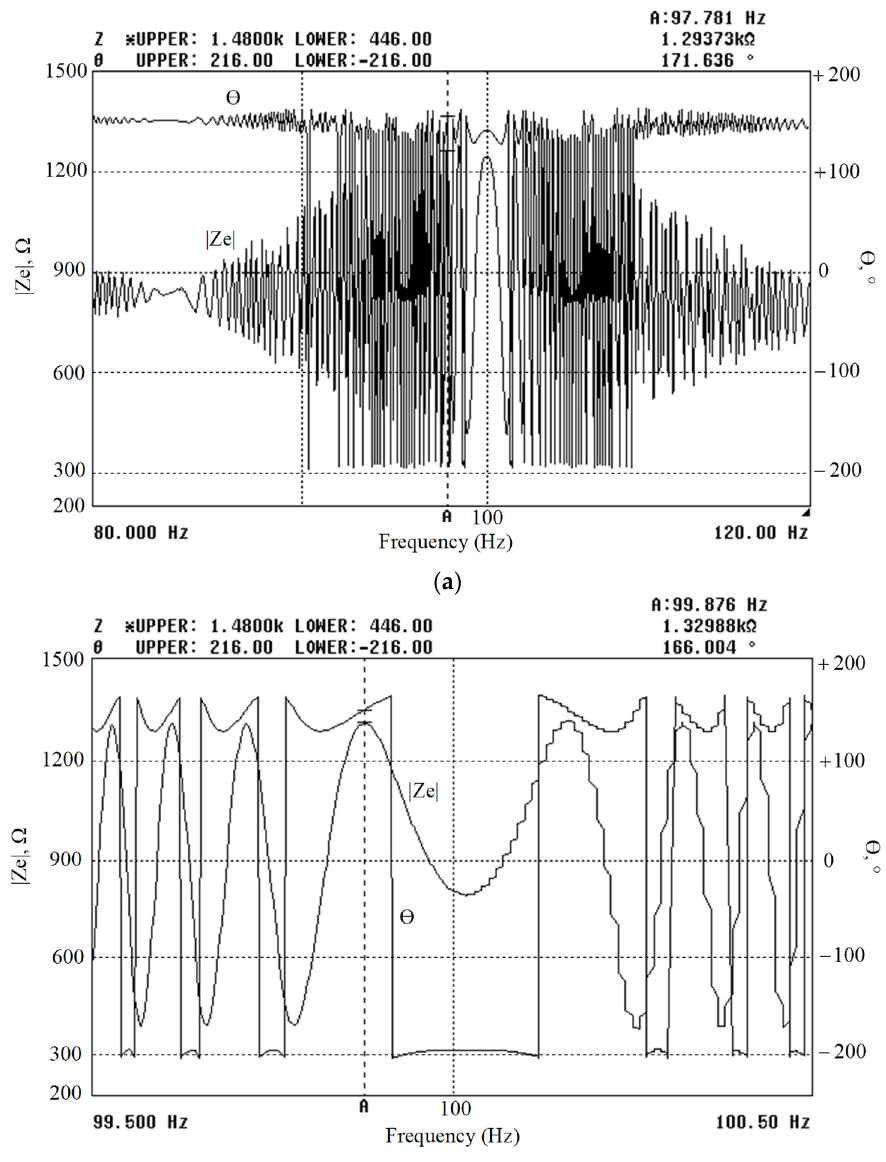
Figure 7. Impedance Z and phase angle θ against frequency for a sample Si/Ag/KNbO 3 /Ag with thicker KNbO 3 film: ( a ) general view and ( b ) re-scaled closer view.